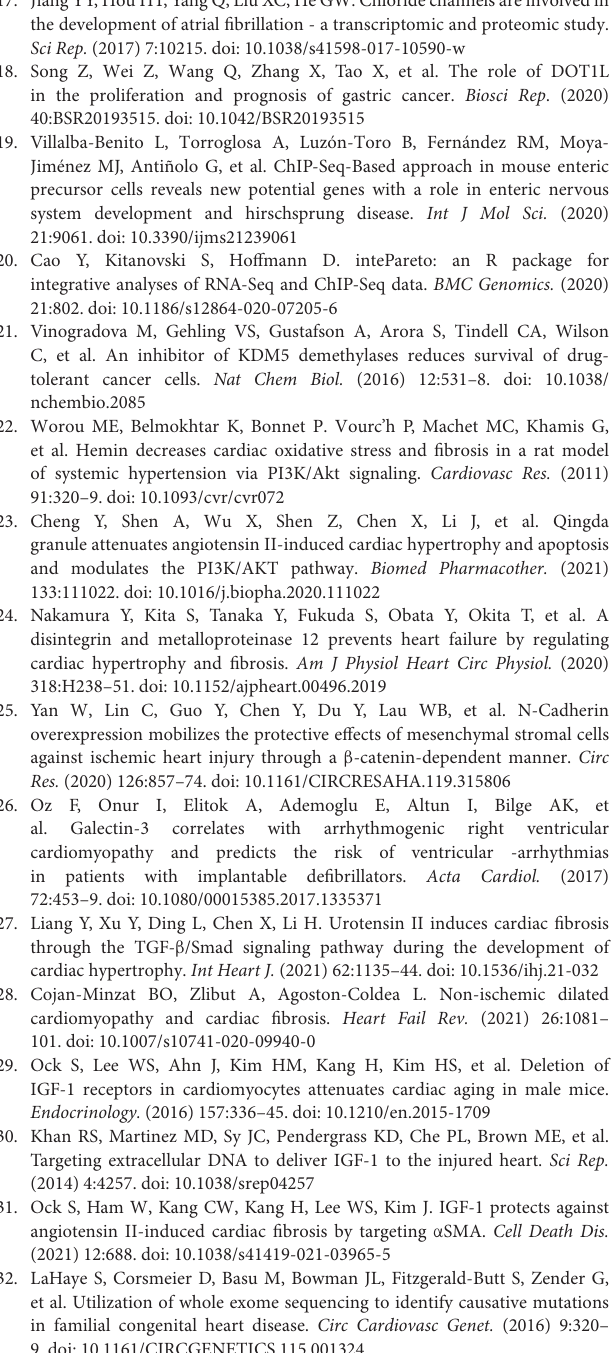
Supplementary Figure 3 | (A) The hub gene network constructed via cytoHubba_Degree for Ang II vs. CFs. (B) The hub gene network constructed via cytoHubba_MCC for Ang II vs. CFs. (C) The hub gene network constructed via cytoHubba_MNC for Ang II vs. CFs. (D) The hub gene network constructed via cytoHubba_EPC for Ang II vs. CFs.